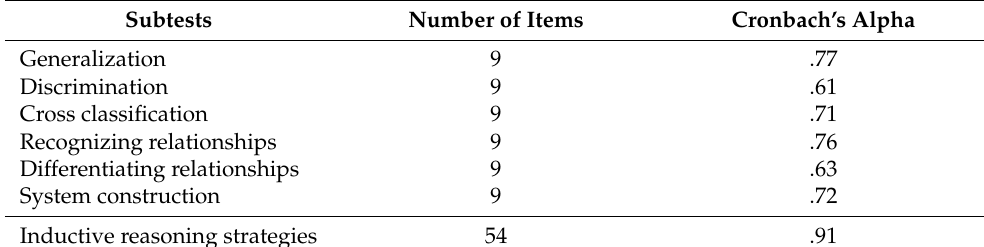
Table 2. The reliability of the instrument and its subtests (Cronbach’s Alpha).